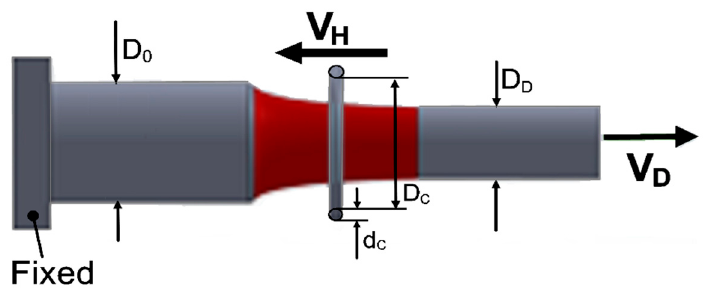
Figure 1. Schematic of a backward non-continuous dieless wire drawing process.